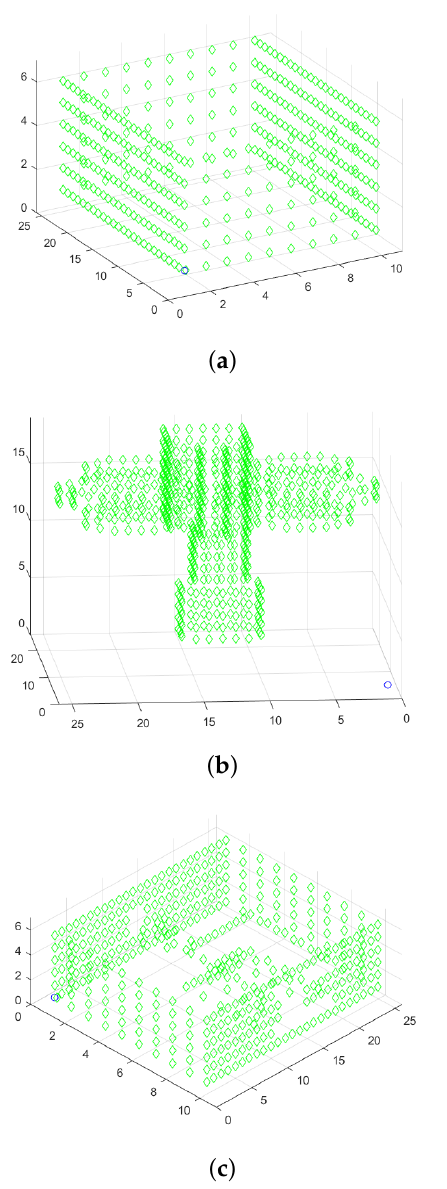
Figure 12. Path of the experiments. ( a ) Plain room. ( b ) Windmill. ( c )